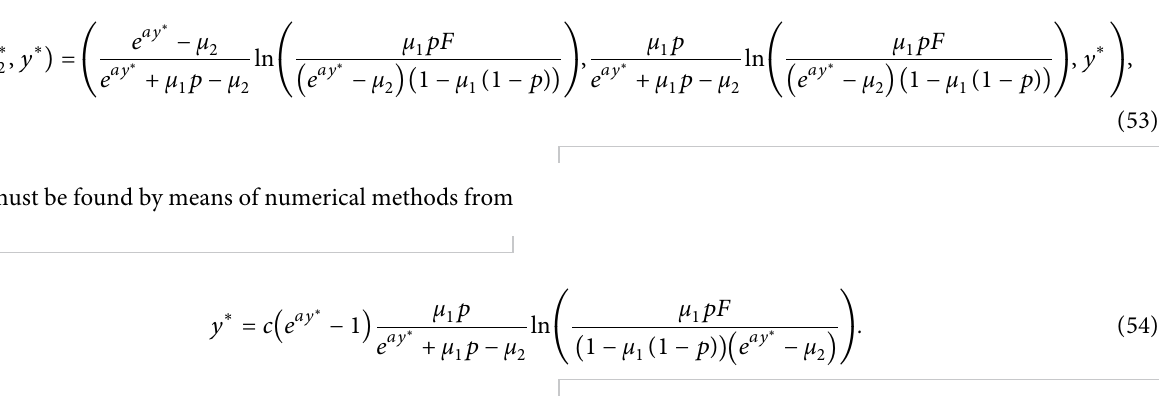
, μ ,p, F,c, a ) � ( 1 , 0 . 5 , 0 . 8 , 15 , 0 . 5 , 2 ) 1 2